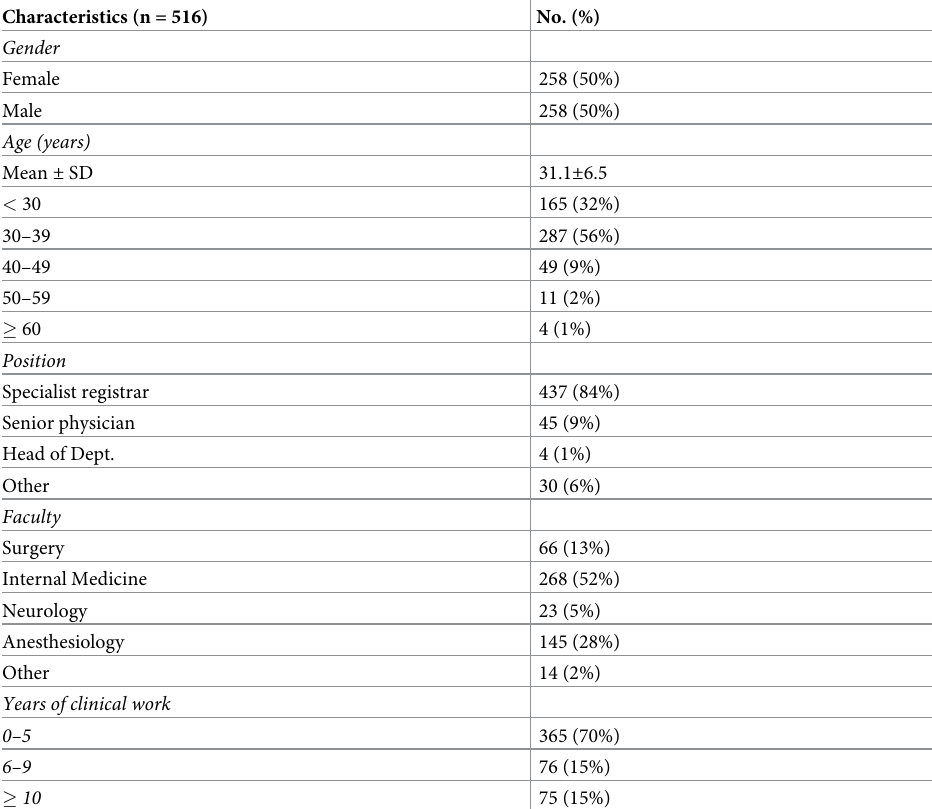
Table 1. Study participants: Demographic